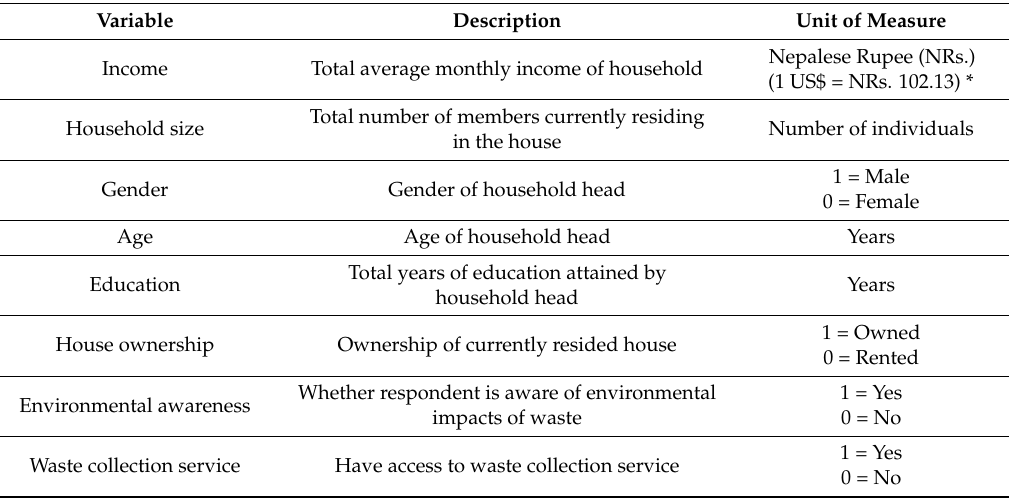
Table 2. Description of explanatory variables used in this